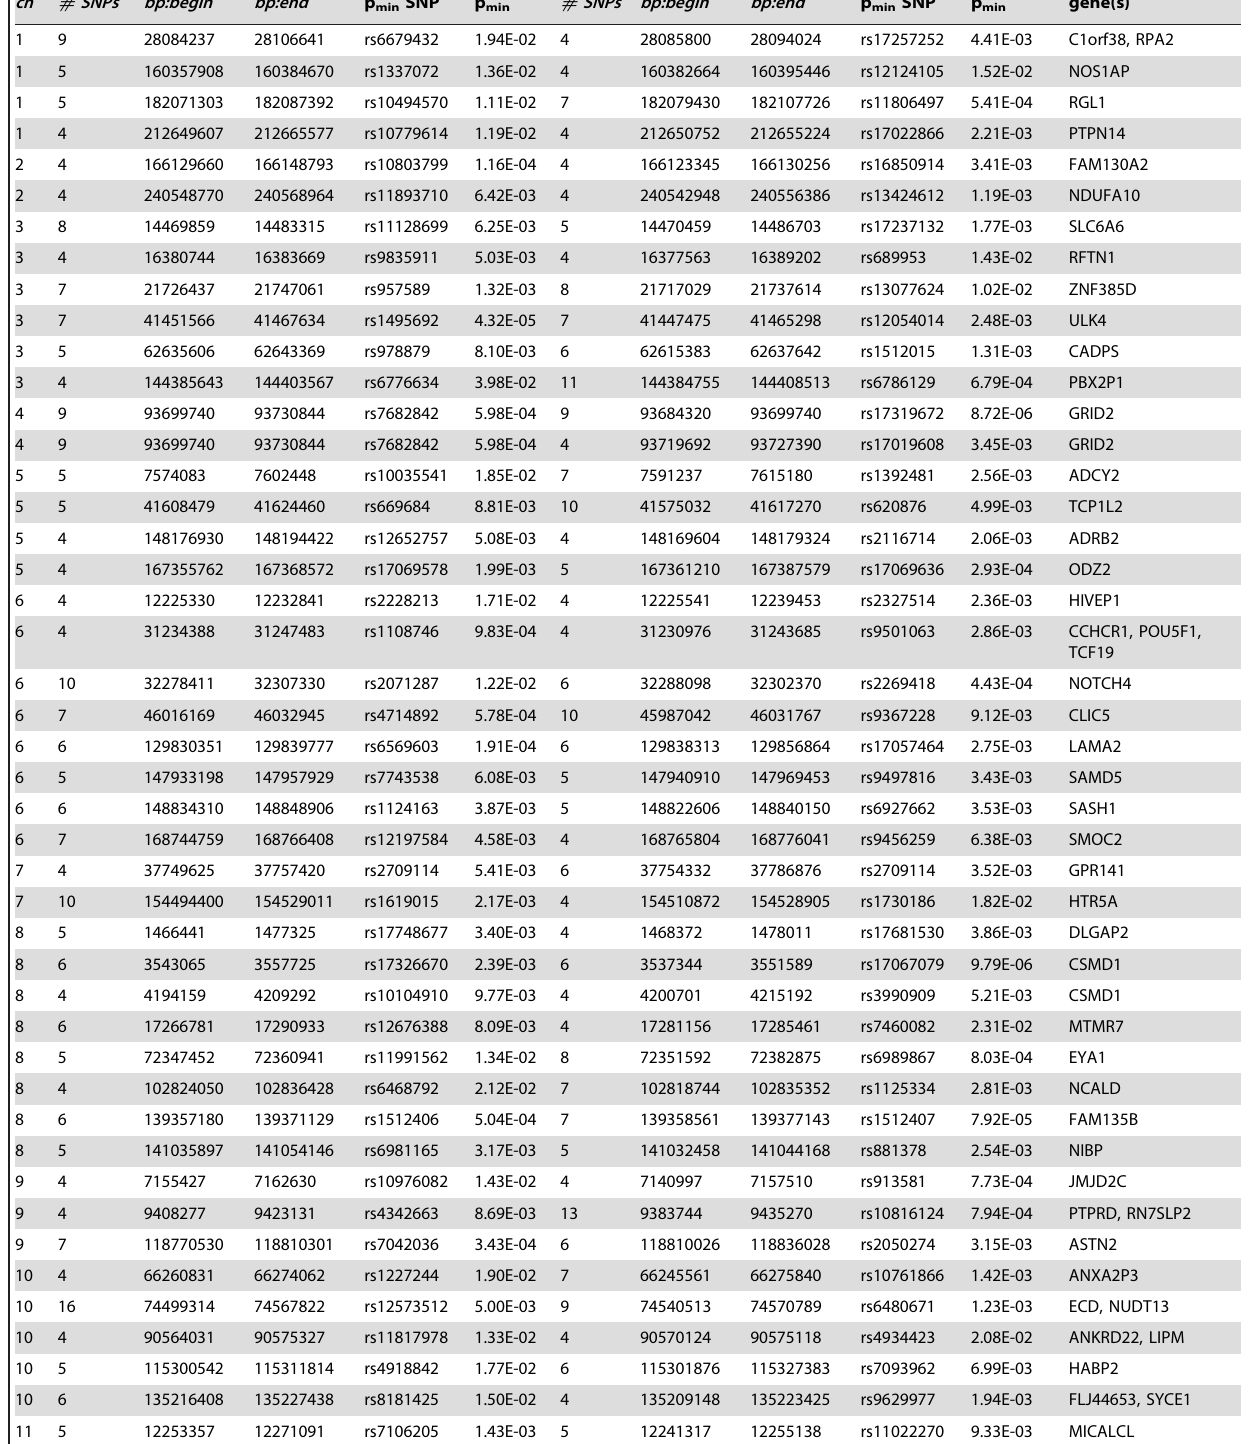
Table 2. Chromosomal regions and genes identified by clusters of SNPs that provide nominally-significant differences between individuals dependent on alcohol (dbGAP alcohol dependent v ctl) or at least one illegal substance (NIDA/MNB drug dependent v ctl) in subjects of African-American